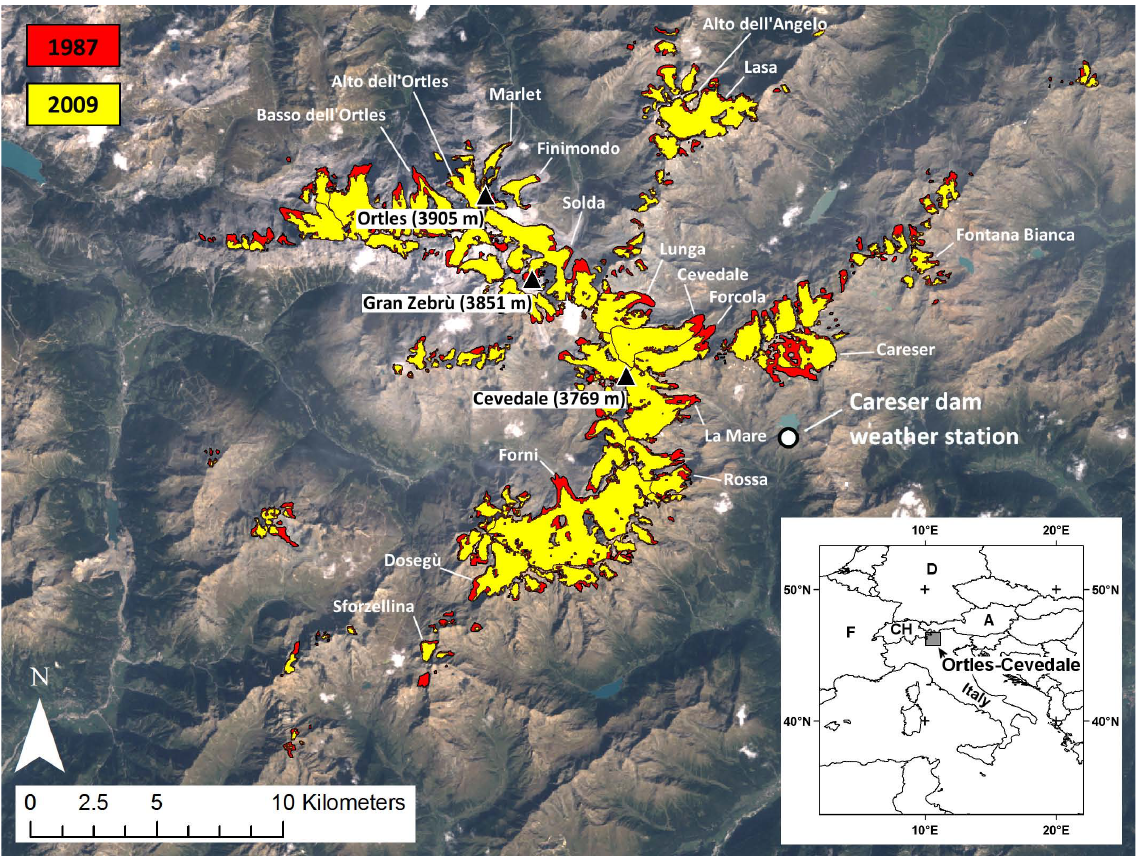
Fig. 1. Geographic setting of the Ortles-Cevedale group with glacier extents from 1987 and 2009. Named glaciers are referred to in the text.